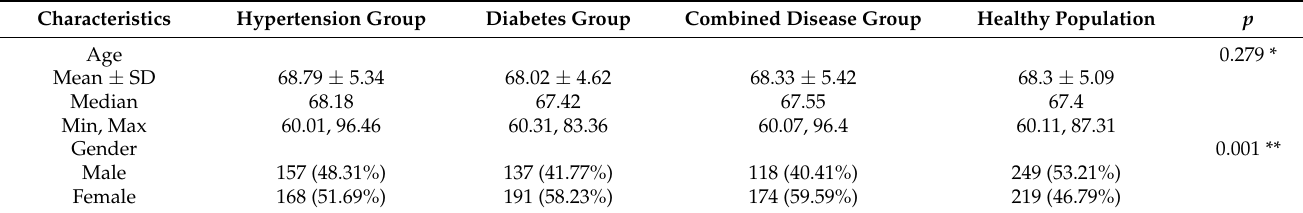
Table 1. Baseline demographic characteristics in the immunogenicity analysis data set (n =